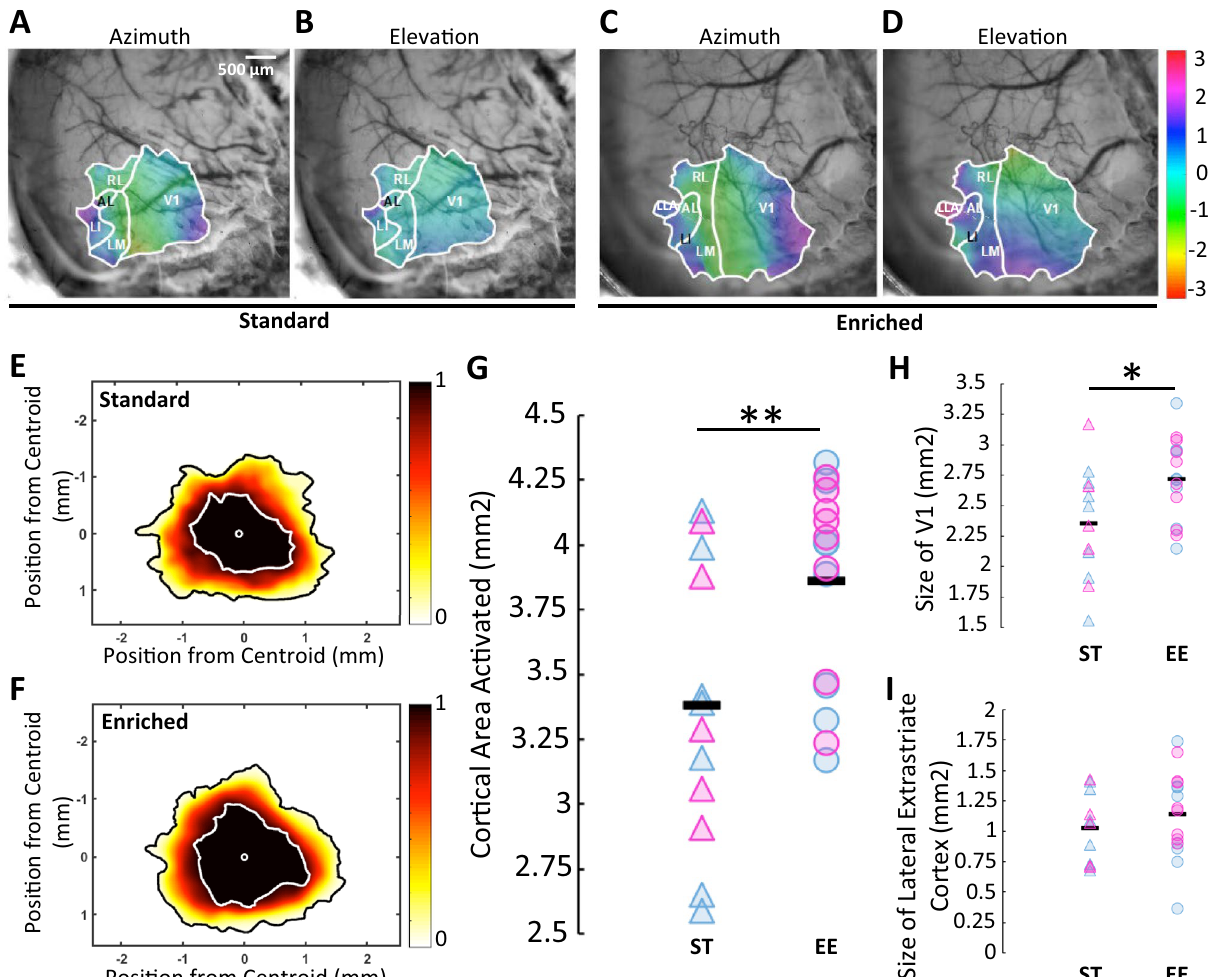
Figure 1. Cortical area activated was determined through retinotopic mapping. Representative maps in azimuth ( A ) and elevation ( B ) of standard mice compared to representative maps in azimuth ( C ) and elevation ( D ) of mice that grew in an enriched environment. Aligned delimitations of the visual cortex (V1 and lateral extrastriate cortex) for standard mice ( E ) and mice reared in an enriched environment ( F ). Colour bars: proportion of experiments. Cortical area activated ( G ), size of V1 ( H ) and size of lateral extrastriate cortex ( I ) for both groups. ( G ) p = 0.0074 (one-tailed Wilcoxon Rank-sum test). **p < 0.01. ( H ) p = 0.0164 (one-tailed Welch’s t-test). *p < 0.025. ( I ) p = 0.1669 (one-tailed Welch’s t-test). In ( G ), ( H ) and ( I ), individual data points represent individual animals. Pink triangle: ST female (5 mice in total); blue triangle: ST male (7 mice in total); pink circle: EE female (8 mice in total); blue circle: EE male (8 mice in total). Black line represents the